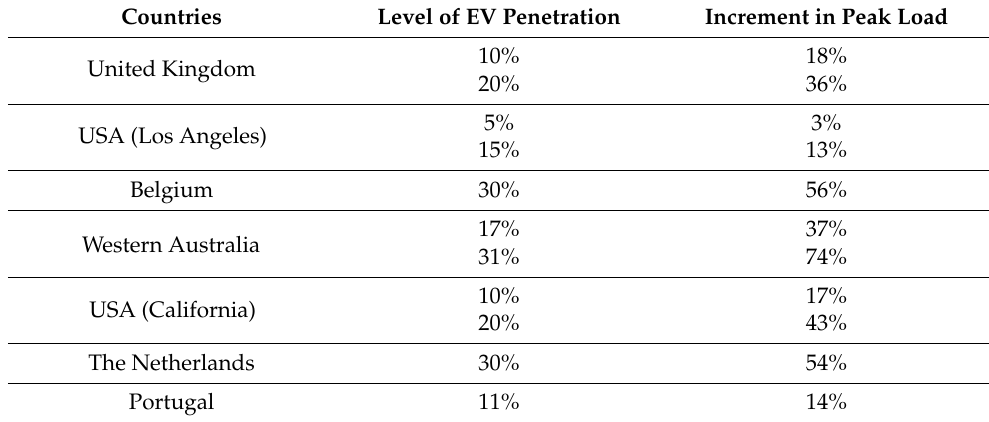
Table 1. Peak load increments simulation results in different countries (based on